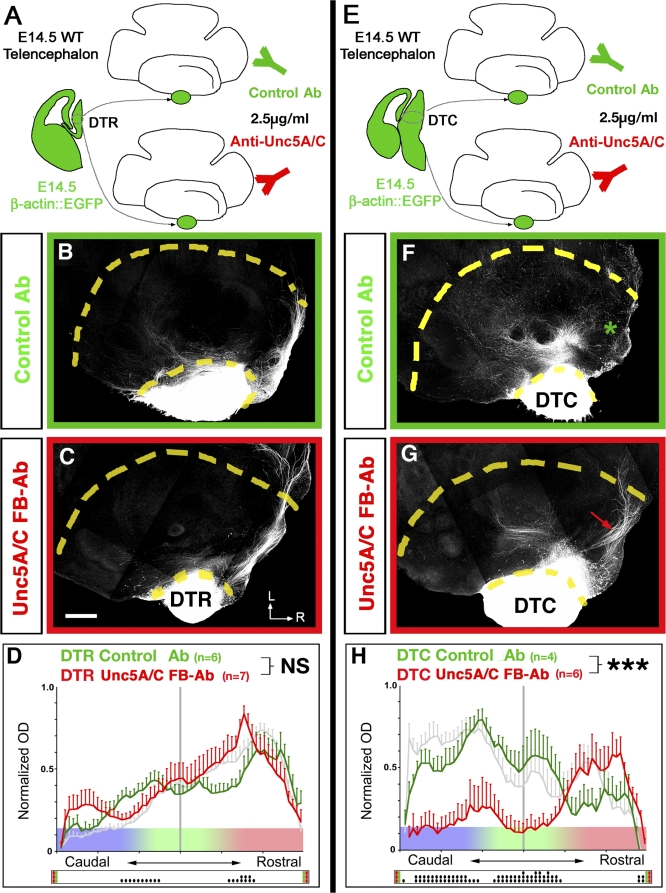
Unc5A and C Receptors Are Required for the Repulsion of Caudal DT Axons from the Netrin-1–Rich Rostral Domain of the Ventral Telencephalon(A and E) Isochronic whole-mount telencephalic cocultures with EGFP-expressing rostral (B–D) or caudal (F–H) DTh explants were incubated either with control isotype mouse IgG (B and F) or function-blocking anti-Unc5A/C polyclonal antibody (Ab) (C and G). Blocking the function of Unc5A/C receptors does not affect the rostral outgrowth of DTR axons (see [C and D]) but induces a significantly more-rostral outgrowth of DTC axons in the VTel (see [G and H]). Quantification of normalized optical density (OD) of DTR-EGFP axons (D) or DTC-EGFP axons (H) growing in VTel with function-blocking anti-Unc5A/C antibodies (red curves) or control mouse anti-IgG antibodies (green curves). NS, nonsignificant (p > 0.05); triple asterisks (***) indicate p < 0.001, ANOVA one-way test (overall effect: bins versus experimental conditions). For comparisons, the gray curves represent the distribution of control DTR axons (in [D]) and control DTC axons (in [H]) cultured without antibody as shown in Figure 5D and 5H. The raster-like dot plot presented under each histogram represents the significance of individual bin comparisons performed between the two experimental conditions using a PLSD-post-hoc test (a single dot [•] indicates p < 0.05; double dots [••] indicate p < 0.01; and triple dots [•••] indicate p < 0.001). L, lateral; R, rostral.